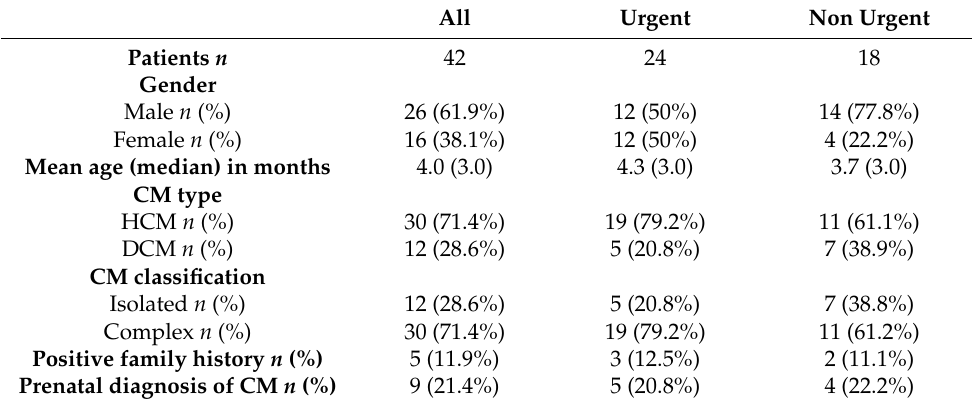
Table 1. Patients’ population